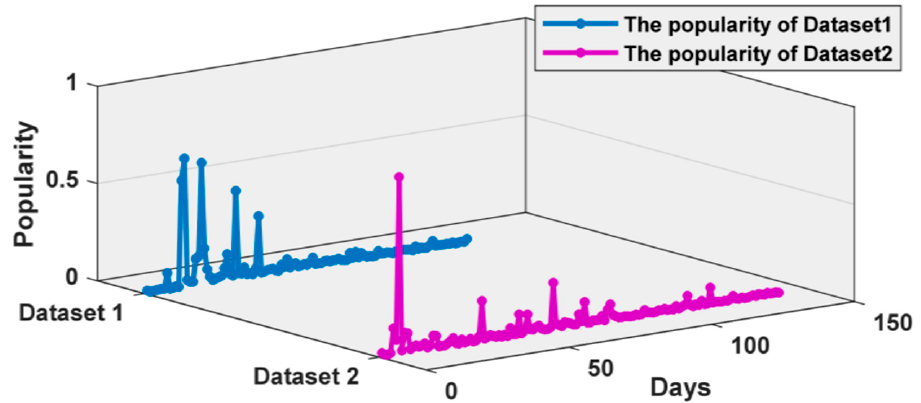
Figure 5. Time series of microblog events on the topic of genetically modified food.